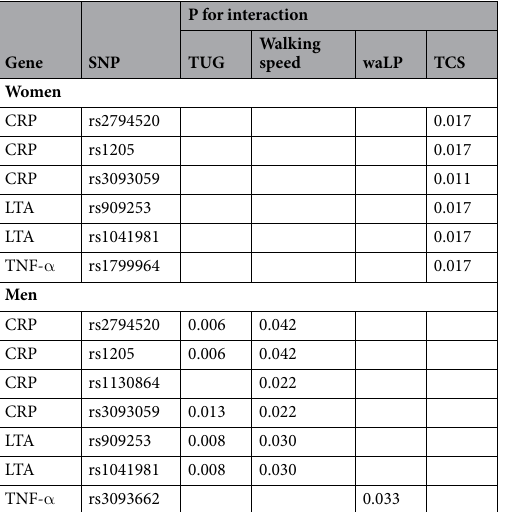
Table 3. Significant gene–physical activity interactions on TUG, walking speed, waLP, and TCS. Additionally adjustment of age, BMI, smoking, drinking, and number of disease